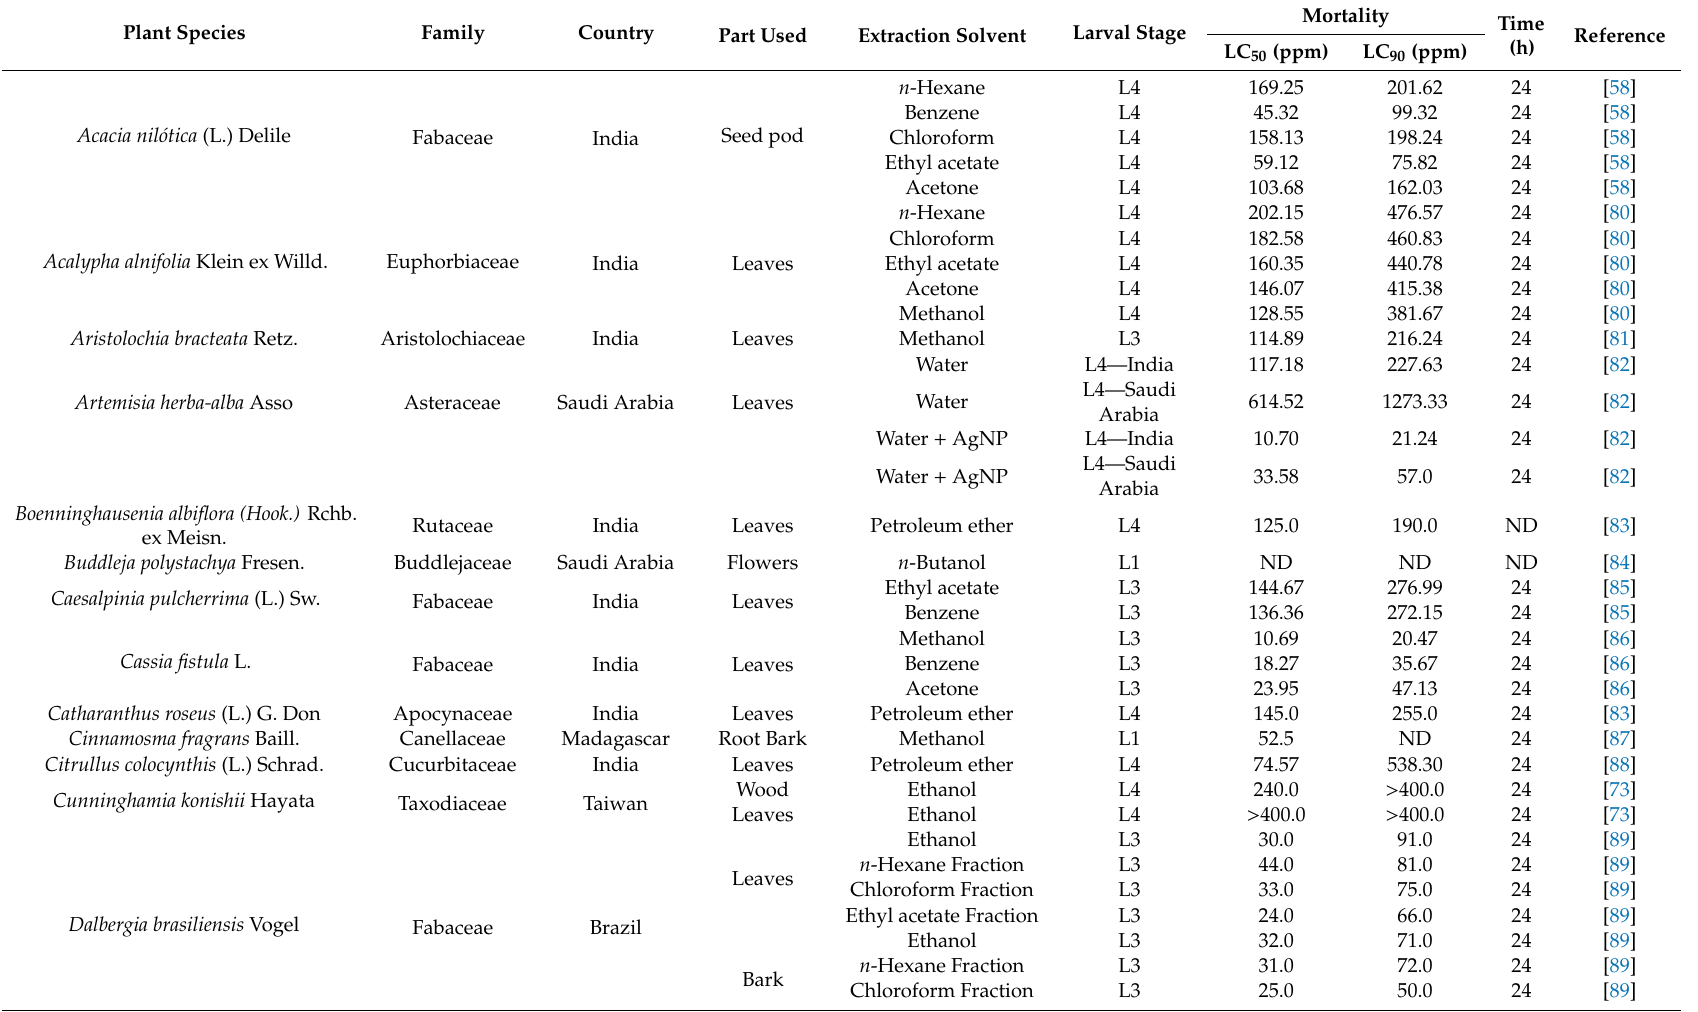
Table 3. Larvicidal activity of organic / aqueous extracts against the Ae. aegypti mosquito. Plant